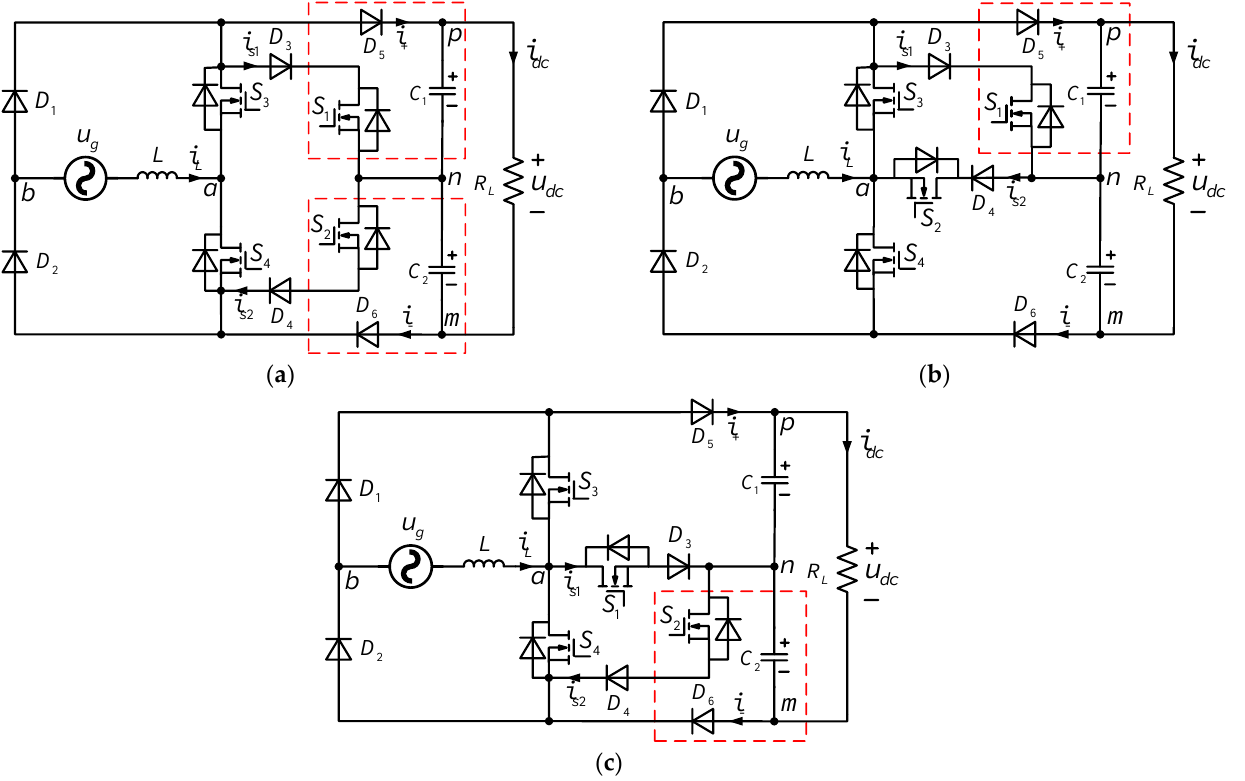
Figure 3. Three novel single-phase three-level PFC. ( a ) STL-PFC. ( b ) UATL-PFC. ( c )